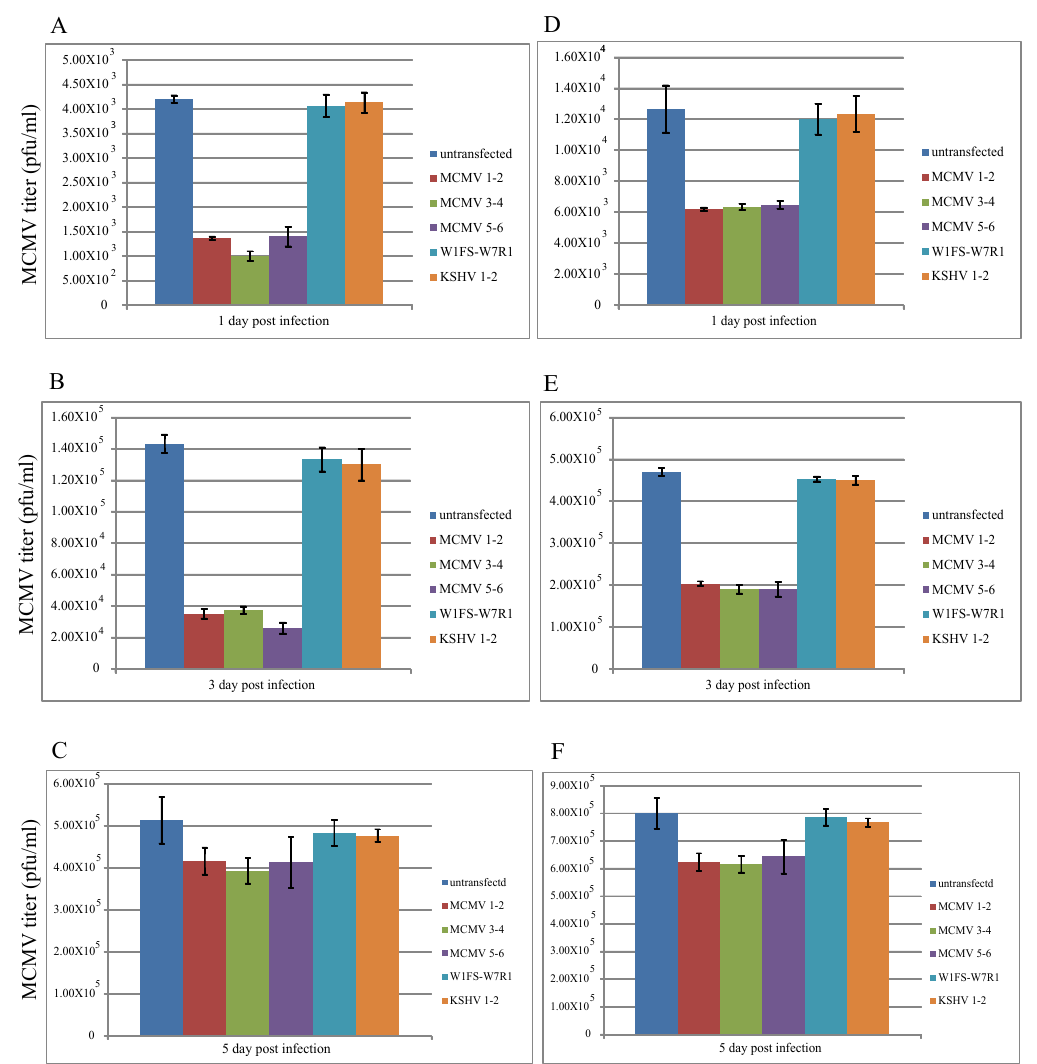
Figure 4. TALEN plasmid transfection was prior to MCMV infection. When using lipofectamine as a transfection reagent, the viral titers were determined 1, 3 and 5 days post infection, respectively, in ( A – C ). When using NKS11 as a transfection reagent, the viral titers were determined 1, 3 and 5 days post infection, respectively, in ( D – F ). All the data are expressed by columns (mean ± standard deviation). However, if the viral infection was prior to the plasmid transfection, we found that TALEN plasmids resulted in no obvious growth inhibition on MCMV at 1, 3, 5 and 7 days post transfection, compared with the controls using lipofectamine or NKS11 as a transfection reagent (Figure